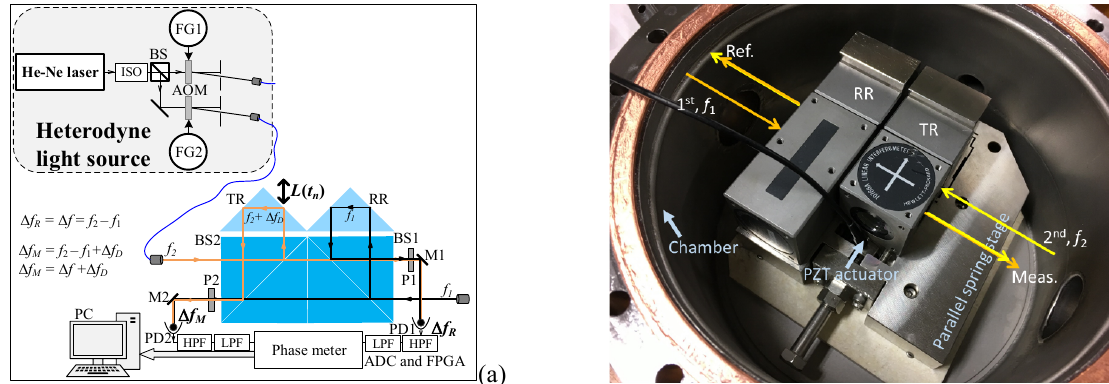
Figure 1. Schematic diagram (a) and photo (b) of the proposed heterodyne interferometer. FG: Function Generator, ISO: Isolator, BS: Beam splitter, TR&RR: Target and reference retro reflectors, PD: Photo detector, P: Polarizer, LPF&HPF: Low-pass &